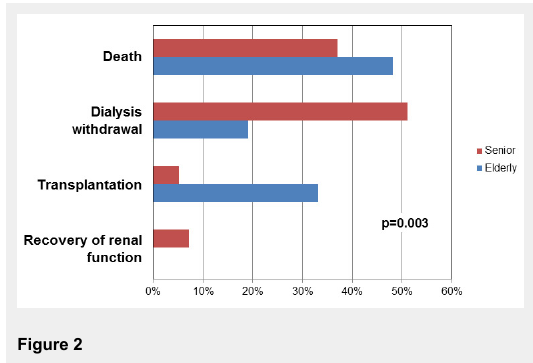
Reasons for cessation of haemodialysis